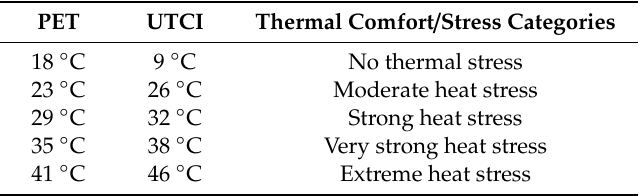
Table 2. Comfort and heat categories for PET and UTCI. Adapt by [29,30].